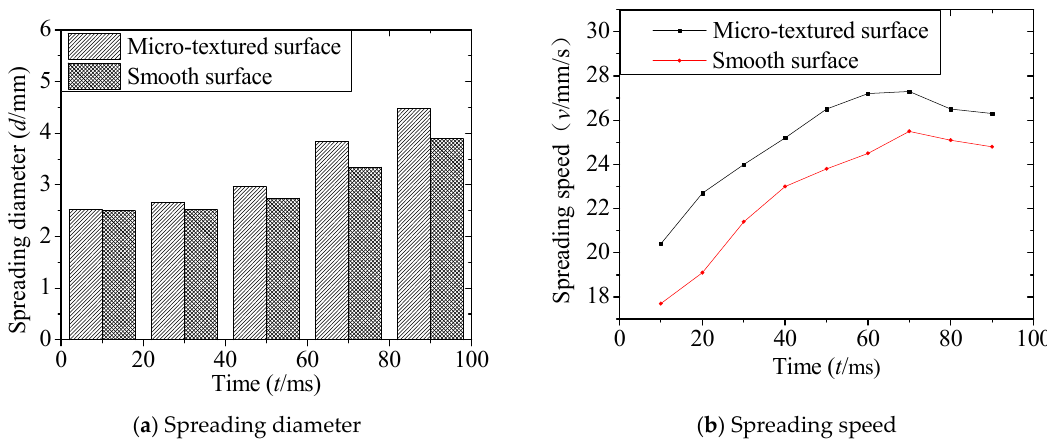
Figure 10. Spread diameter and velocity of drop on micro-textured and smooth surfaces over time.